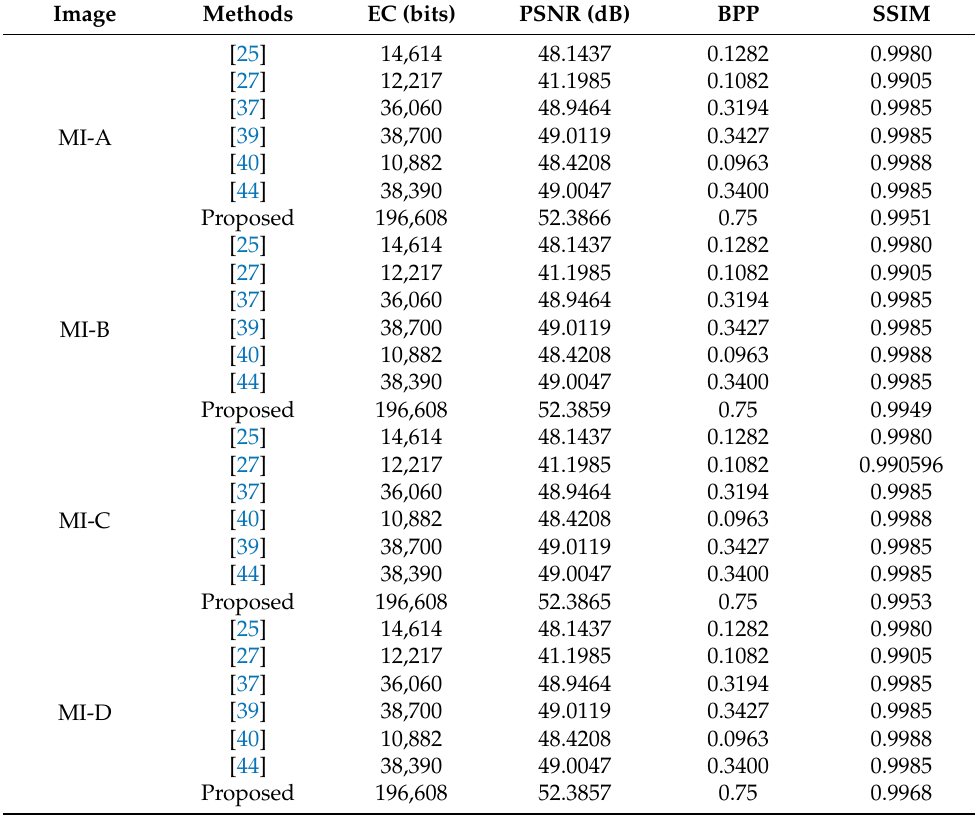
Table 6. Comparison in terms of quality